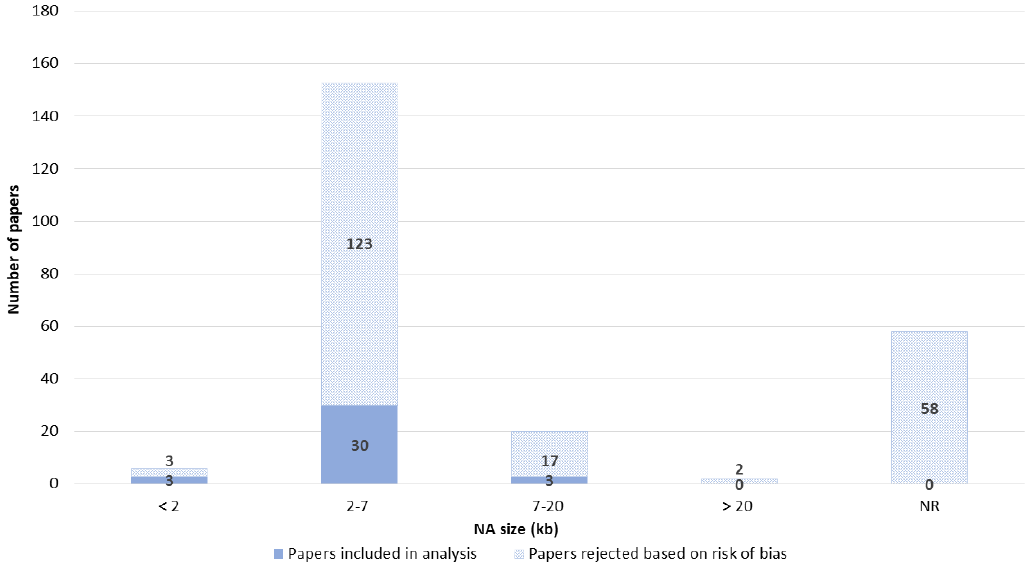
Figure 8. Size of NA. NR—not reported.